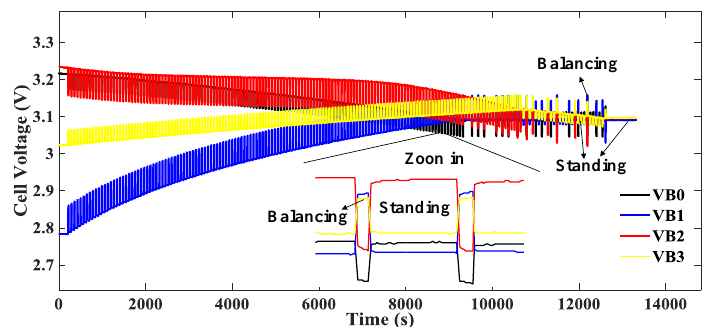
Figure 18. The voltage equalization results for four cells.